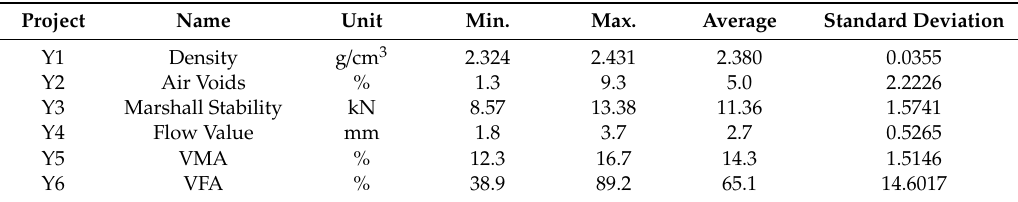
Table 9. Total test